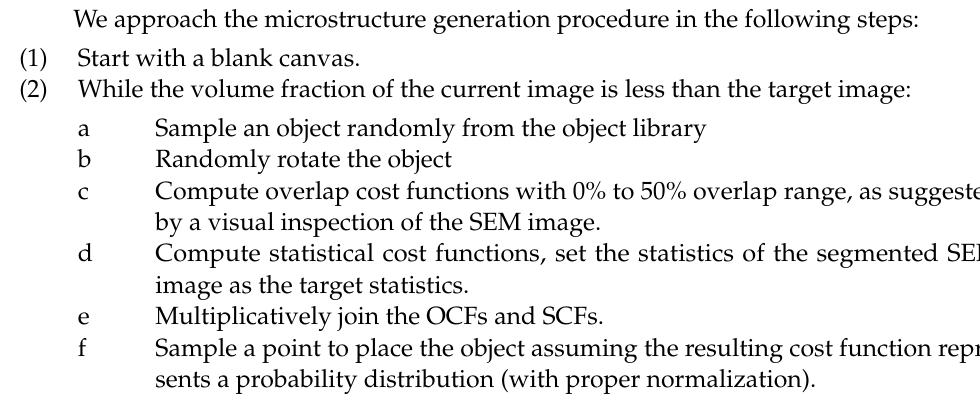
Figure 13. The object library mined from Figure 12 for the generation of statistically similar micro- structures.